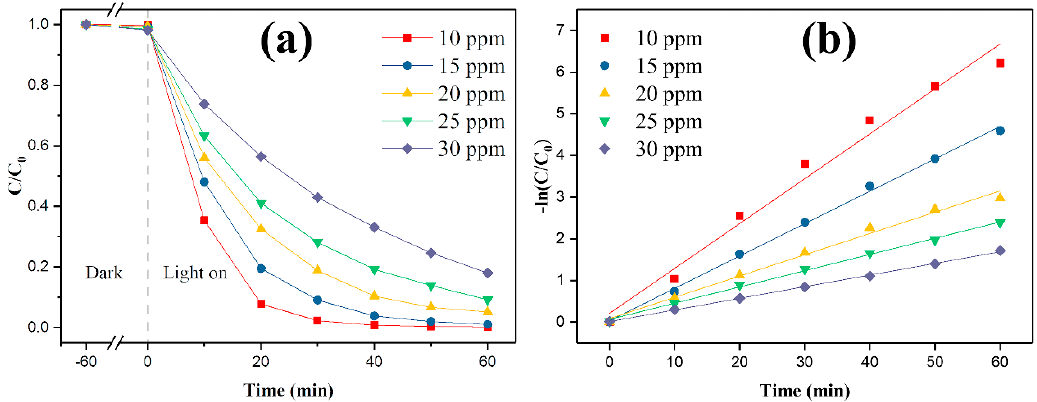
Figure 5. Effects of different initial concentrations on the degradation of methyl orange by 0.6-SiO 2 -M-7.5/TiO 2 composite photocatalyst ( a ); degradation kinetics curve ( b ).